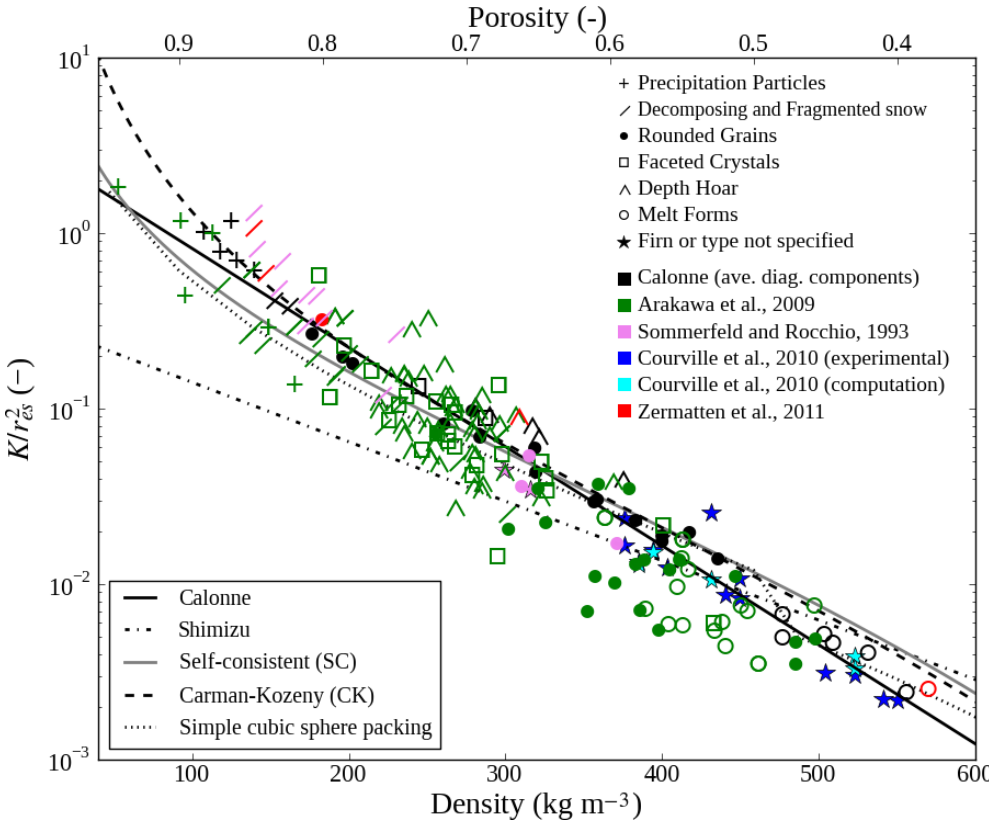
Fig. 4. Dimensionless permeability vs. snow density. Our K ∗ values (in black) are compared to results from other studies (in color). Symbols correspond to the ICSSG (Fierz et al., 2009), excepting stars which are used when firn is considered or when the snow type is not specified in the paper. Analytical models and fits are also plotted.